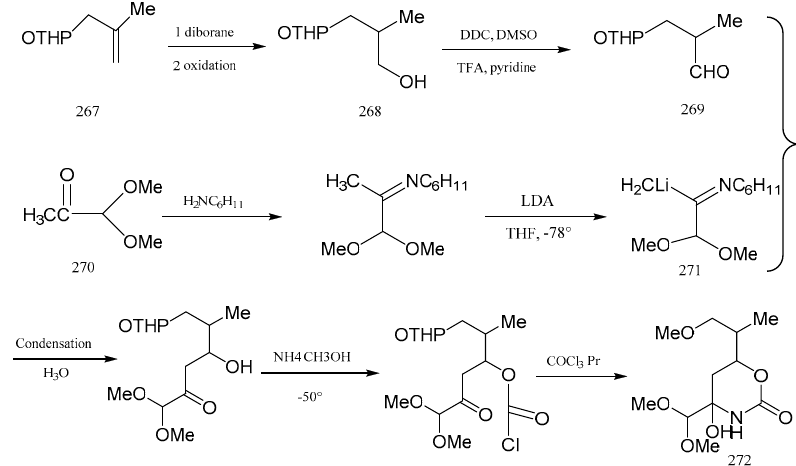
Figure 8. The synthetic by-products of the eastern fragments of maytansine.